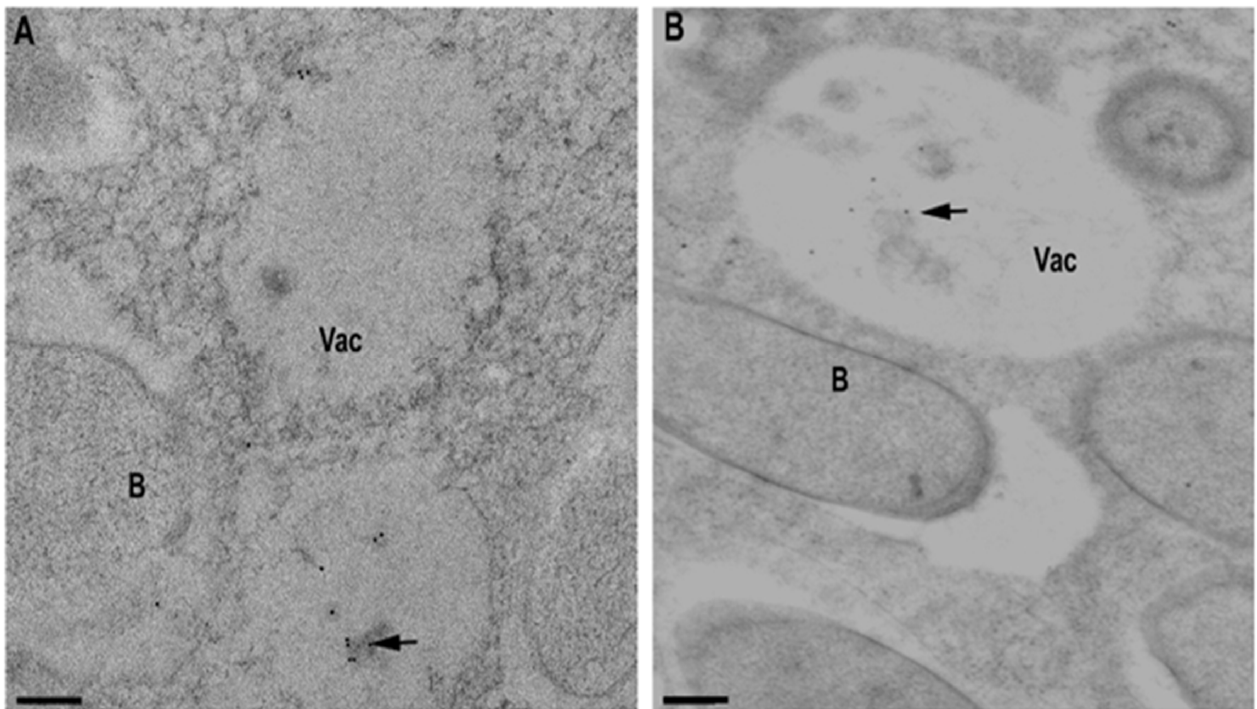
Figure 3. Electron microscopy immunolocalization of MtNHX7 ( A ) and MtNHX6 ( B ). Note the immunogold signal in the small vacuoles (~1000 nm). Bar: 200 nm. Vac: vacuole, B: bacteroid, arrow: immunogold signal.